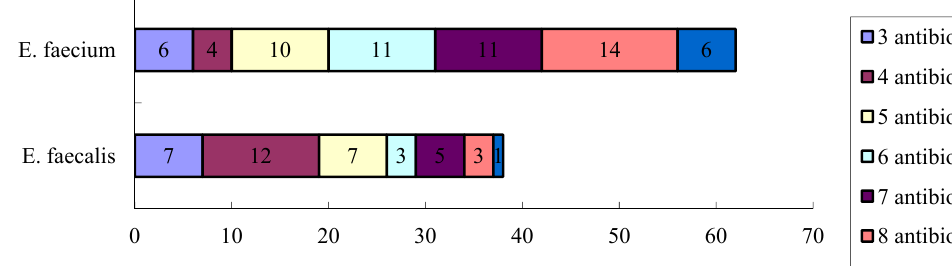
Figure 1. Antimicrobial resistance in 100 multiple-drug resistant enterococcal